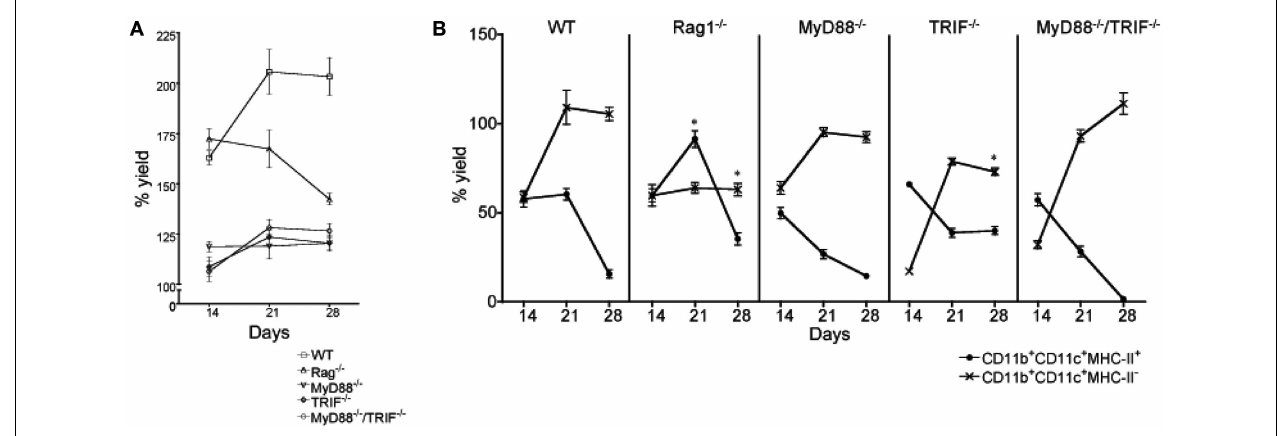
mutant co-cultures was significantly different fromWT ( p ≤ 0.05). (B) Non-adherent cells were collected at 14, 21, and 28days and stained with fluorochrome-conjugated antibodies specific for CD11c, CD11b, and MHC-II to detect subsets of L-DC and cDC-like cells as described in Figure 5 .The % yield of live CD11c + CD11b + MHC-II − L-DC and CD11c + CD11b + MHC-II + cDC-like cells in co-cultures from individual mice was estimated relative to input cell number using flow cytometric analysis. Data represent mean ± SE. Data points identified by * are significantly different ( p < 0.01)